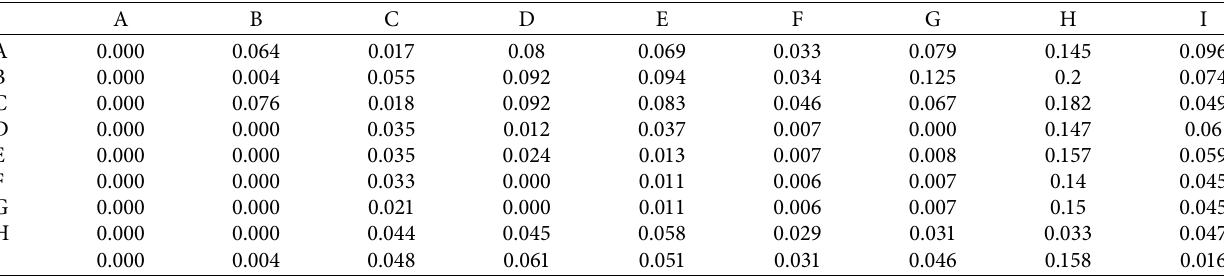
Figure 2: The causal diagram for the total influencing factors. Table 19: The comprehensive influence matrix.